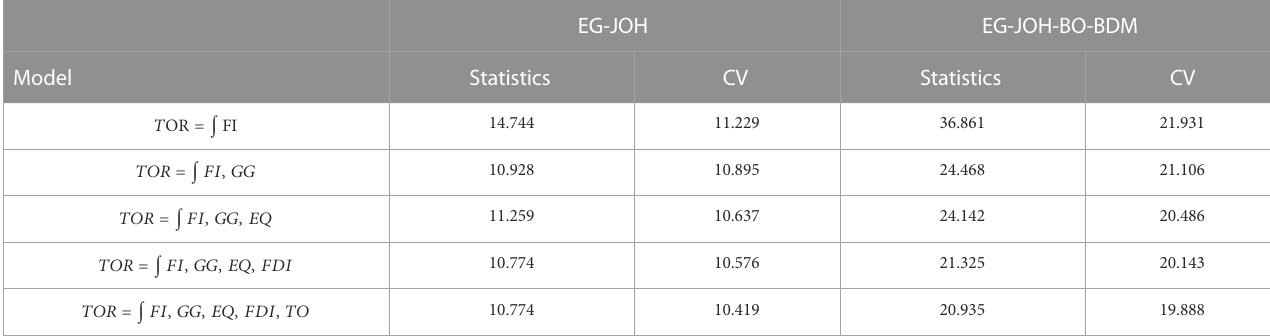
TABLE 6 Results of combined cointegration test.